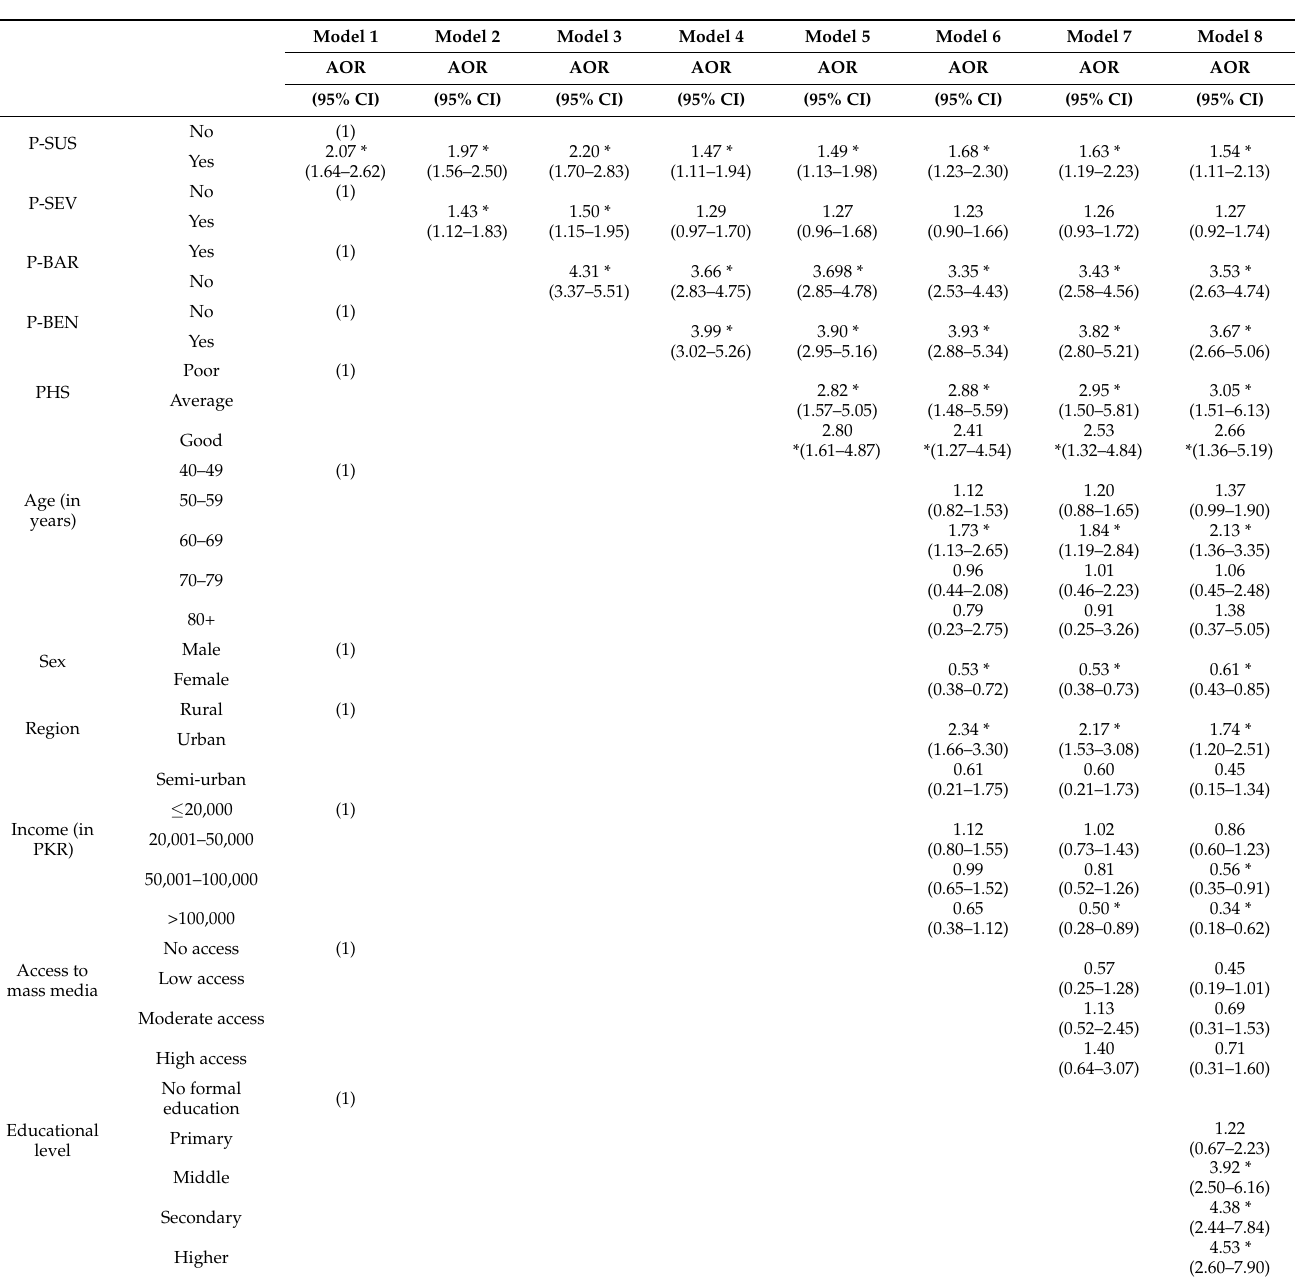
Table 4. Multiple hierarchal regression analysis for factors affecting vaccination